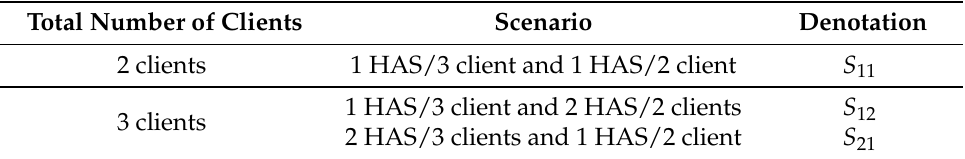
Table 1. Summary of the experimental